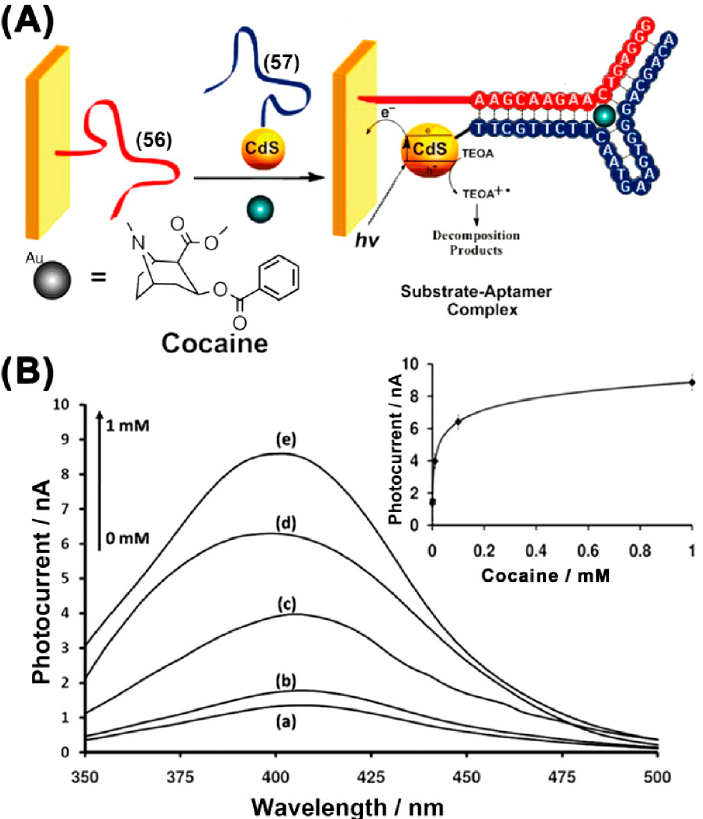
Figure 7. ( A ) Photoelectrochemical cocaine sensor with the self - organization of cocaine/aptamer subunits on an Au electrode. ( B ) Photocurrent action spectra with the analysis of different concentrations of cocaine [46].